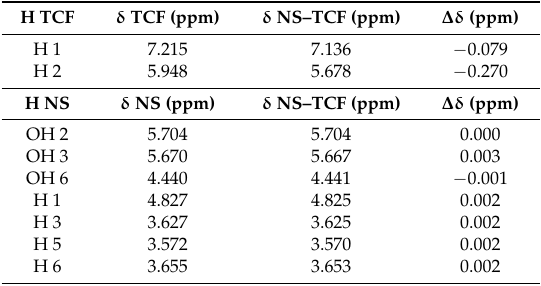
Table 2. 1 H-NMR assignments and chemical shifts for pesticides and NS–2,3,4,6-tetrachlorophenol (TCF) complex.